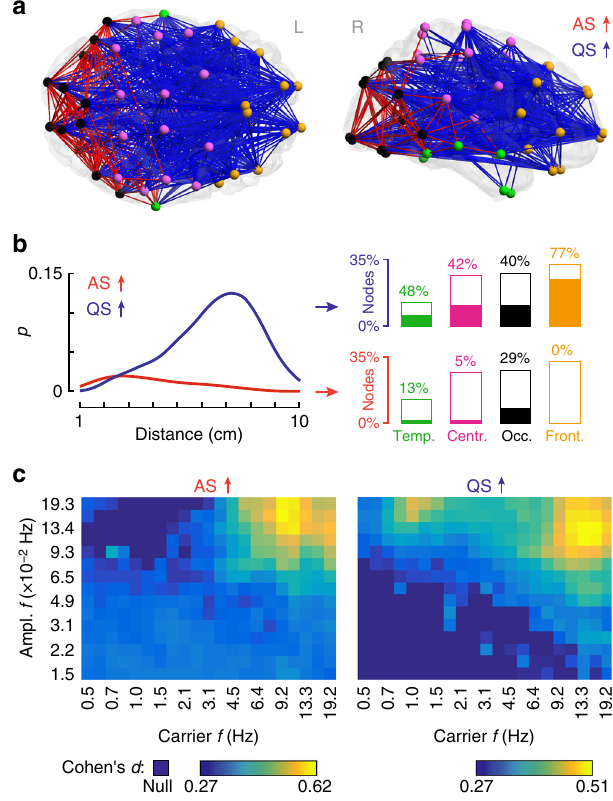
Fig. 2 Changes in cortico-cortical functional connectivity as a function of sleep state. a The main effect of sleep state in the alpha band shows signi fi cant connectivity differences in two main cortical networks (red: AS> QS, blue: QS > AS; both p FWER < 0.0002, paired two-tailed t -test). Distinct cortical regions are coded with different colors: temporal (green), central (pink), occipital (black), and frontal (orange). b These networks have different characteristic length distributions and distinct cortical region distributions. Curves are distributions (kernel density estimates) of functional connection lengths given by the fraction of edges p (normalized to the whole network) for AS (red) or QS (blue). Bar plots show participation of broad cortical areas in each sleep-related network. Filling of the bars denotes the percentage of involved nodes within each region and height denotes each region's share in the whole network. c Spectral fi ngerprints of AS (left) and QS (right) sleep. Color scale shows effect size (Cohen ’ s d ) of sleep contrasts centered at different carrier and amplitude frequencies ( f ). Darkest blue shade denotes frequency combinations where there were no suprathreshold edges